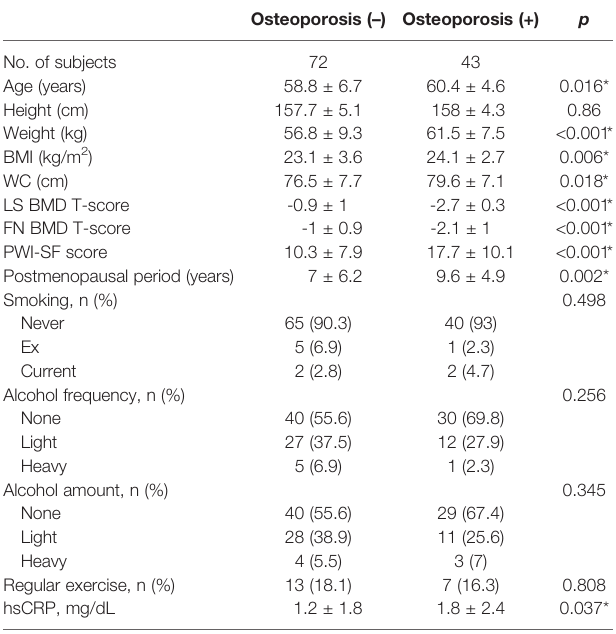
TABLE 1 | Baseline clinical characteristics of